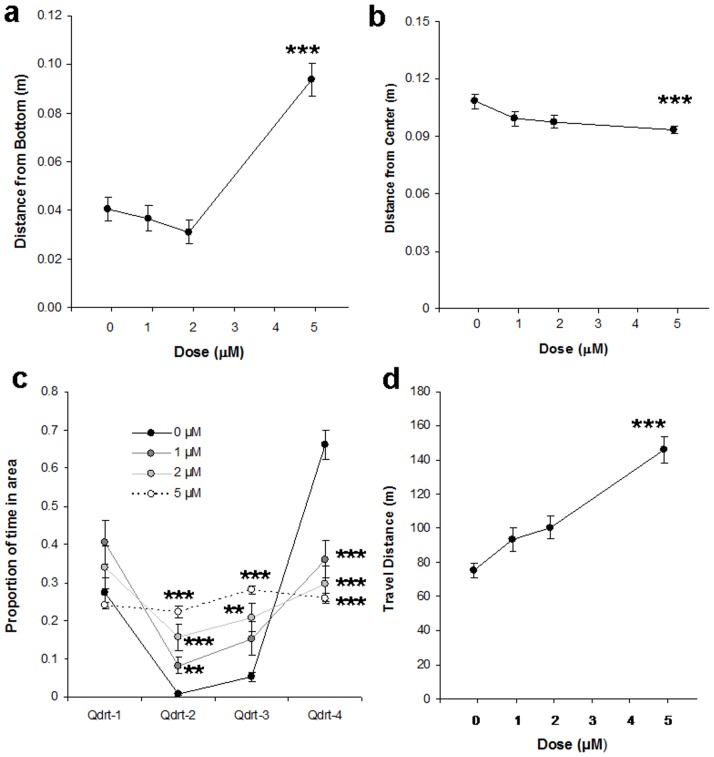
Non-social behaviors of the homogeneous shoals in experiment 1.(a) Distance from bottom increased significantly for 5 µM MK-801. (b) Distance from center decreased significantly for 5 µM MK-801. (c) The temporal distribution over the four quadrants became more homogeneous with higher concentrations of MK-801. (d) Travel distance was increased for 5 µM MK-801. Means ± SEMs are shown. Significant differences between MK-801 groups and controls: **p<0.005; ***p<0.001. For 0, 1 and 2 µM MK-801, n = 20. For 5 µM, n = 19.